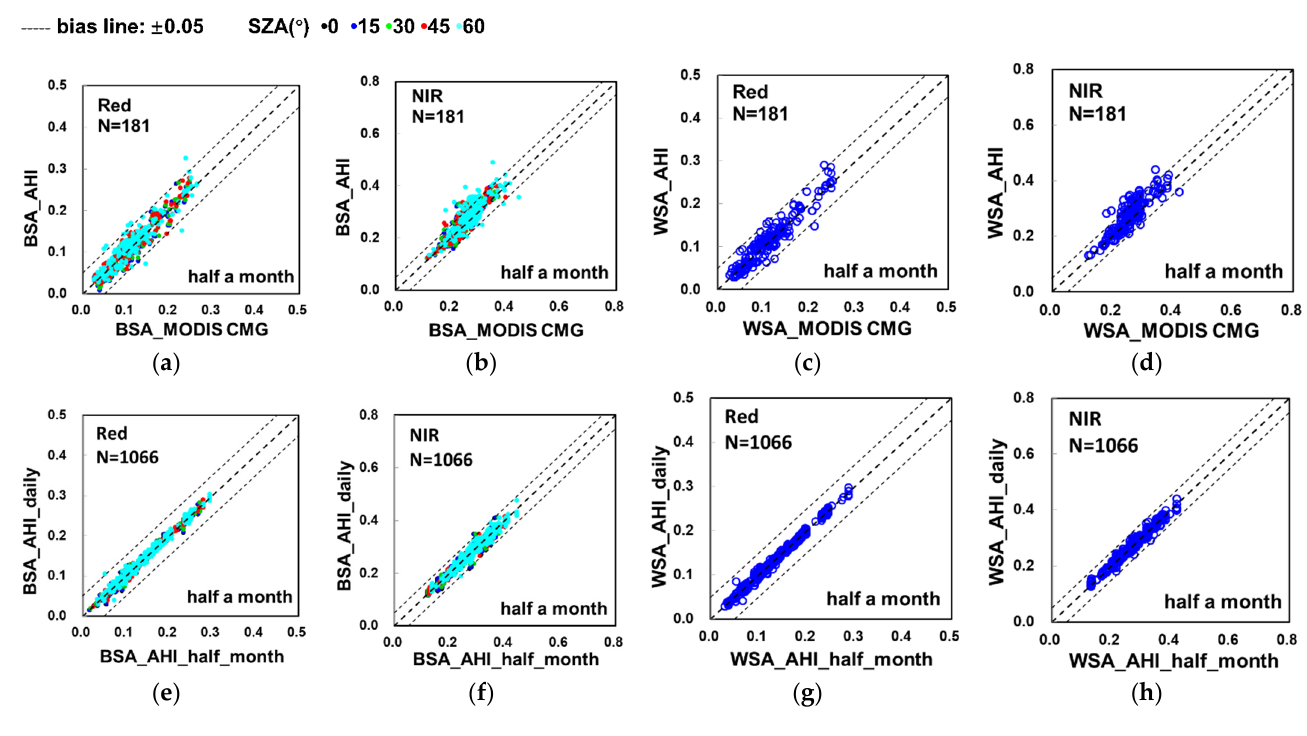
Figure 12. Comparisons of BSA and WSA that were retrieved from the AHI- and MODIS CMG- accumulated observations during a day and half a month. ( a , b ) Comparisons of BSA that were retrieved from MODIS and AHI in the red and NIR bands, respectively, and the colours indicate the BSAs at different SZAs. ( c , d ) refer to similar results as ( a , b ) but for WSA. ( e – h ) refer to similar results as ( a – d ) but for those retrieved from half-month and daily accumulated AHI data. Table 9. Discrepancies in the retrieved albedos between the high-quality AHI and MODIS CMG observations (number ≥ 7, WoD ≤ 2).